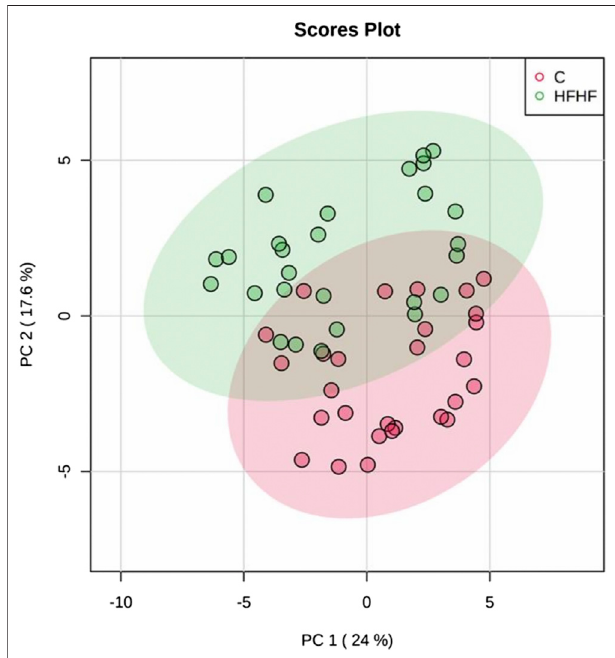
FIGURE 4 | Metabolomic analysis of HFHF induced fatty liver. Principal component analysis (PCA) of control and high-fat high-fructose fed rat at different time